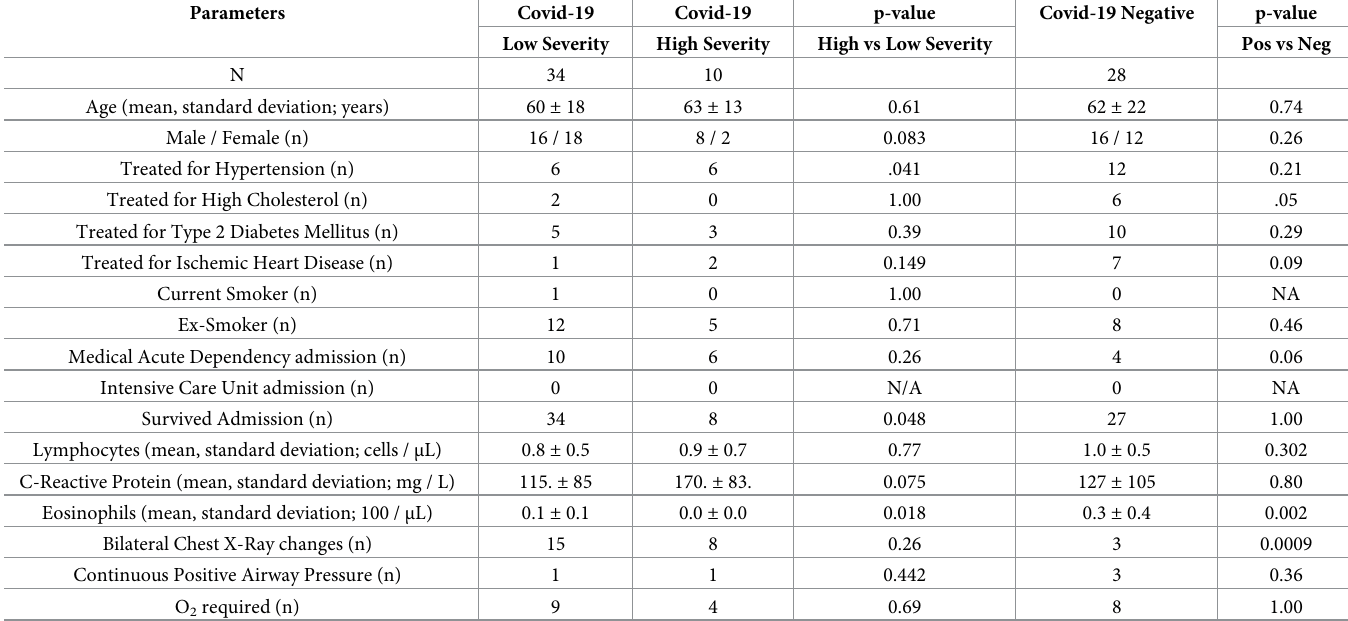
Table 1. Summary of clinical characteristics by participant cohort.